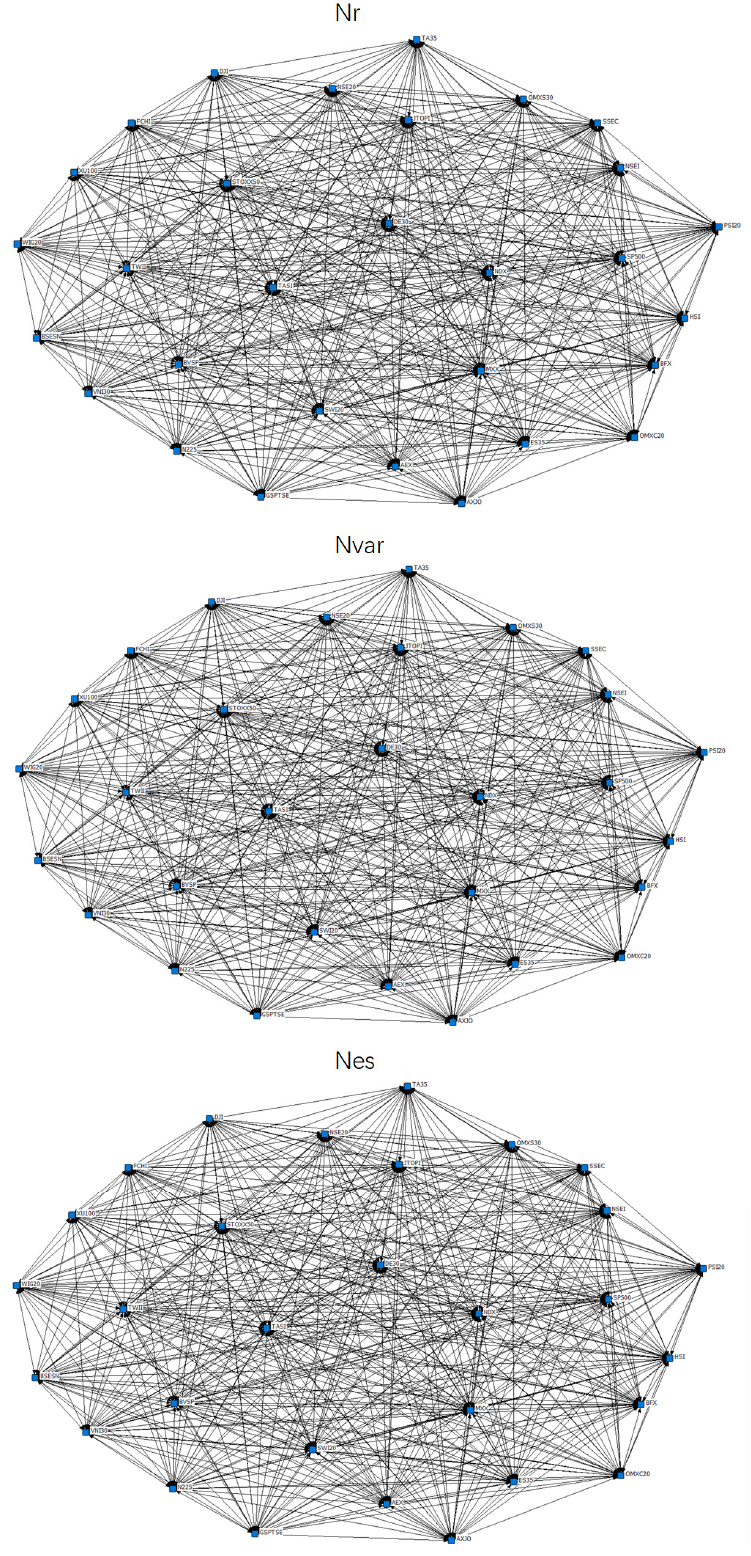
Figure 4. Illustration of Constructed Networks. Note: Top left is an illustration of network N r ; top right is network N var ; bottom is network N es